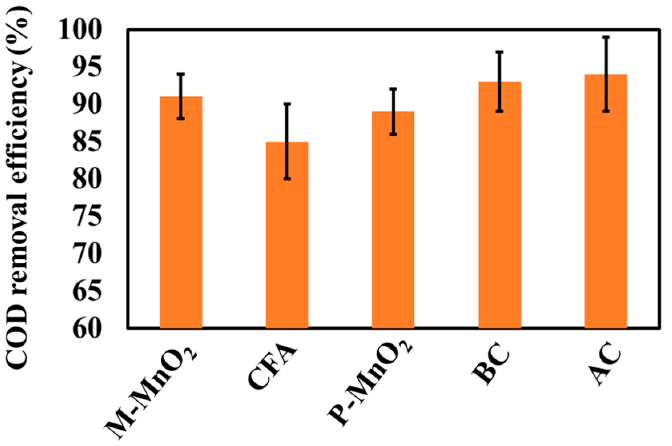
Figure 4. Average COD removal efficiency values with deviations of the five units with the different cathode assemblies (P-MnO 2 , M-MnO 2 , CFA, BC, AC) versus time.